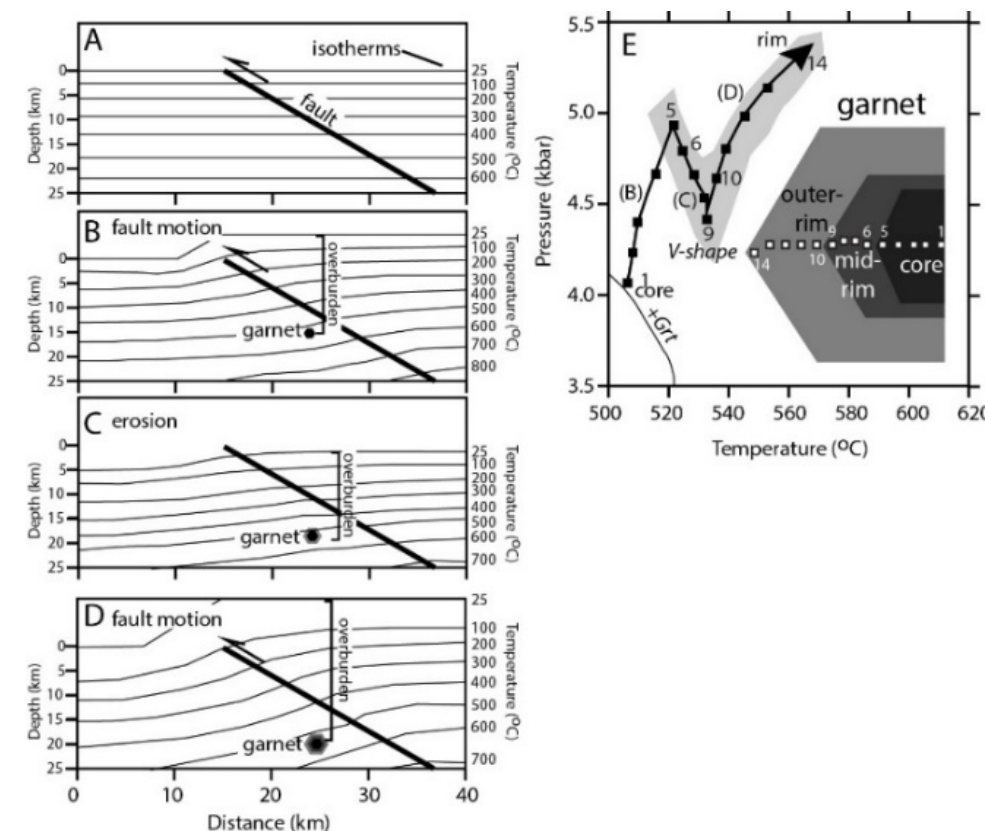
Figure 17. Schematic model for how the V-shaped P-T paths may have developed after [55]. ( A ) Boundary conditions of a depth vs. distance grid with isotherms overlain. ( B ) Fault motion occurs and rocks are buried. Garnet forms due to burial. The garnet records the overburden P. ( C ) A period of erosion occurs. The overburden decreases, but T increases to grow garnet. The garnet records a P decrease due to erosion. ( D ) Fault motion occurs again, and the garnet is buried. ( E ) P-T diagram showing the path taken by the growing garnet. The cartoon inlay represents where analytical data points are taken from the core, mid-rim, and rim of the garnet, and correspond to the numbers on the P-T path. The V-shaped portion of the P-T path is indicated by the grey area on the path. Letters on the path represent where the sample is located in panels ( B – D ).